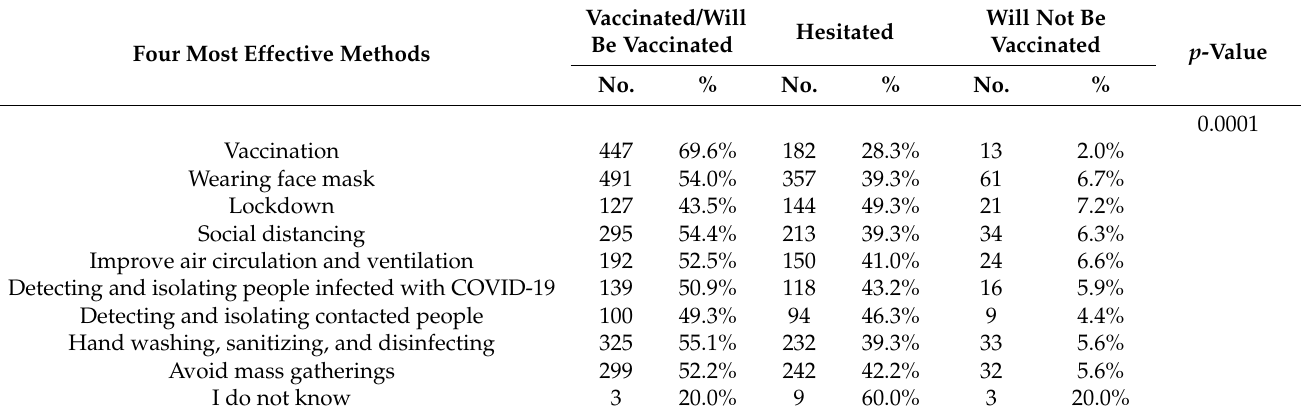
Table 7. Respondents’ beliefs about effective methods of COVID-19 prevention, and their willingness to be vaccinated for